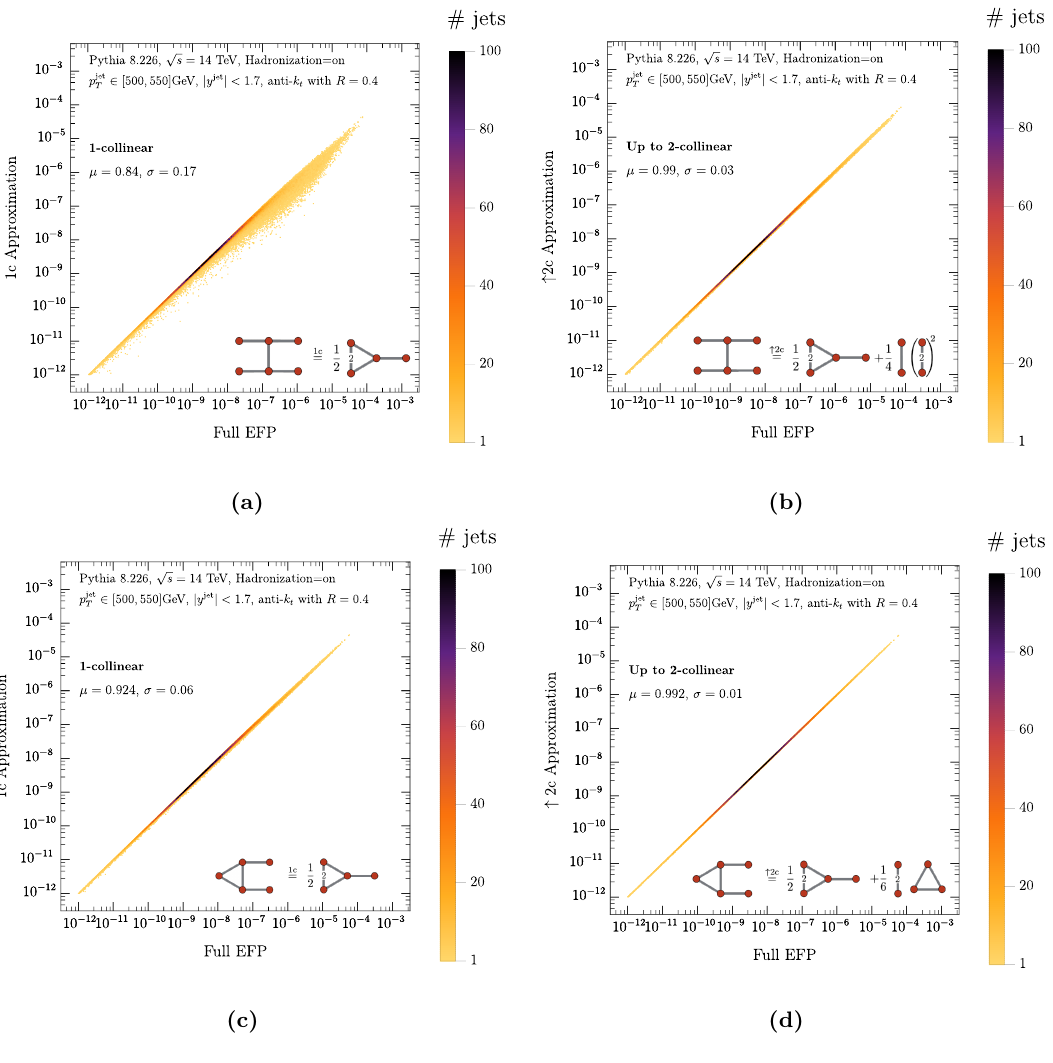
Figure 7. Testing the relationship for the “H” EFP in eq. (2.25) (top row) and “A” EFP in eq. (2.28) (bottom row) in the 1-collinear approximation (left column) and including the 2-collinear approximation (right column), which leads to a substantial improvement. The average µ and standard deviation σ of the ratio is